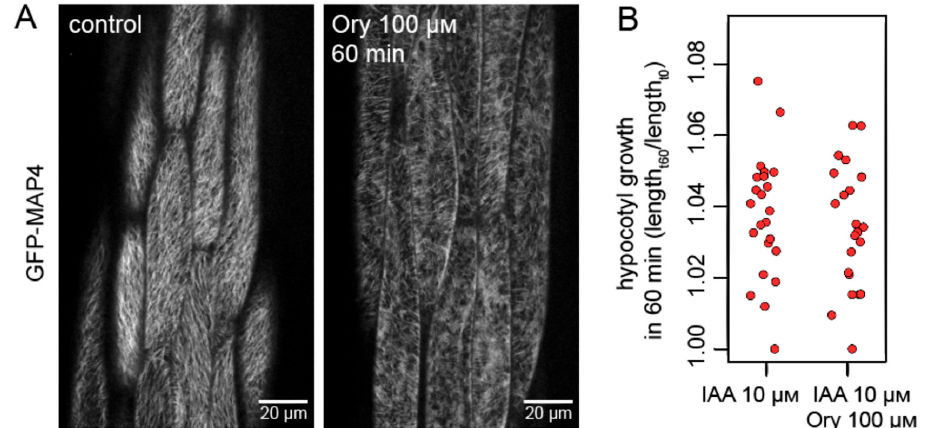
Figure 4. Intact microtubule arrays are not necessary for the promotion of hypocotyl growth by auxin. ( A ) The e ff ect of oryzalin in A. thaliana hypocotyl segments. A majority of microtubules auxin. ( A ) The effect of oryzalin in A. thaliana hypocotyl segments. A majority of microtubules are disrupted after 60 min of oryzalin (100 μ M) treatment. The GFP fluorescence is depicted in grayscale. ( B ) Elongation of isolated hypocotyls during one hour of auxin treatment (IAA, 10 μ M) after the disruption of microtubules by oryzalin (100 μ M). Oryzalin was applied as a pre-treatment for 60 min.